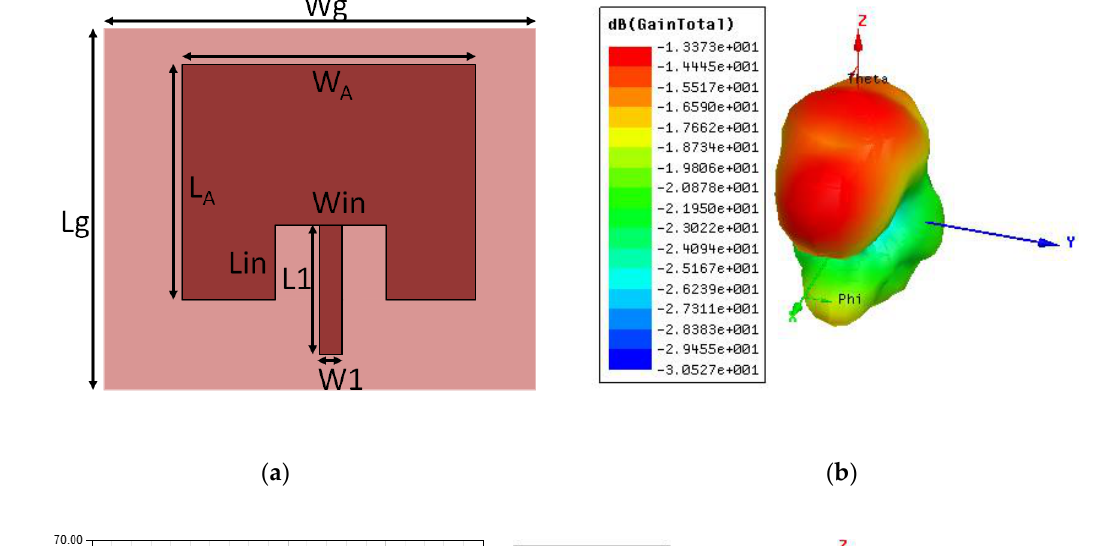
(31) V 0+ is the power voltage. The generation of harmonics, including the odd harmonics, can be described by solving Equation (32)